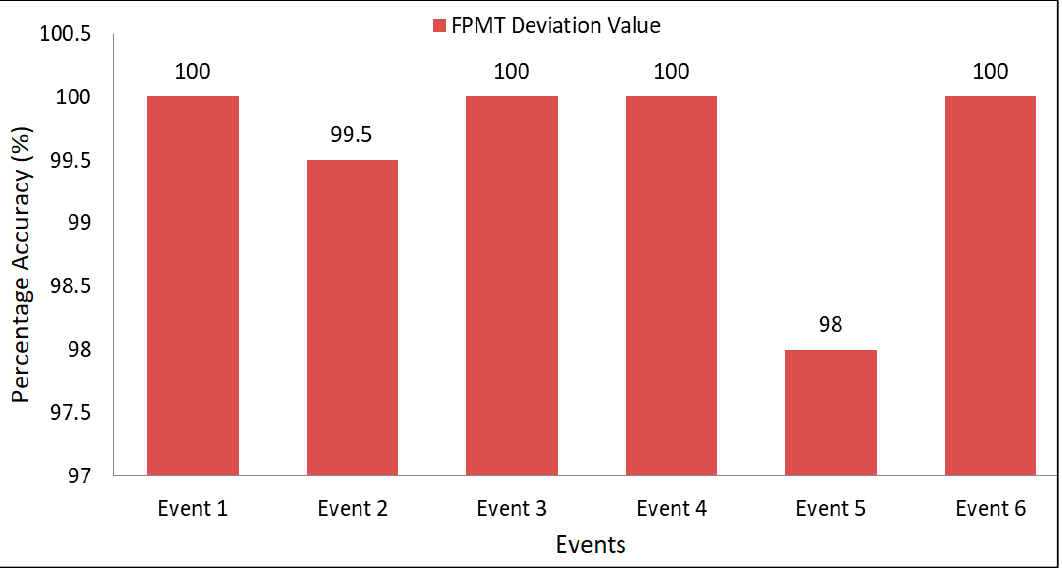
Figure 14. The real fault location and detected fault location using improved FPMT technique.